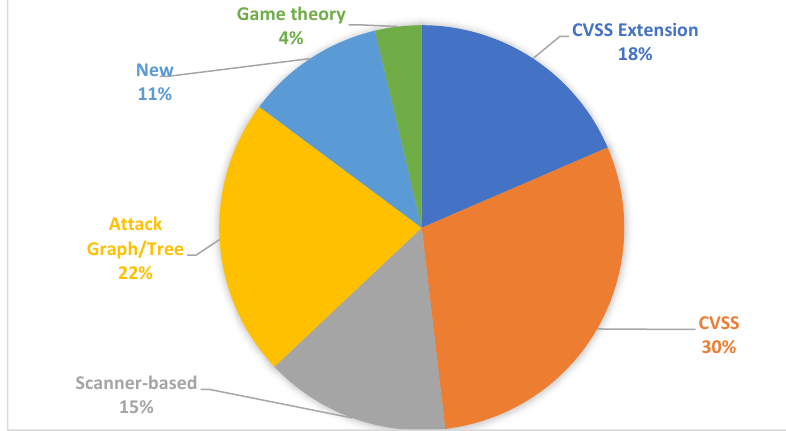
Figure 10. Distribution of vulnerability assessment frameworks.